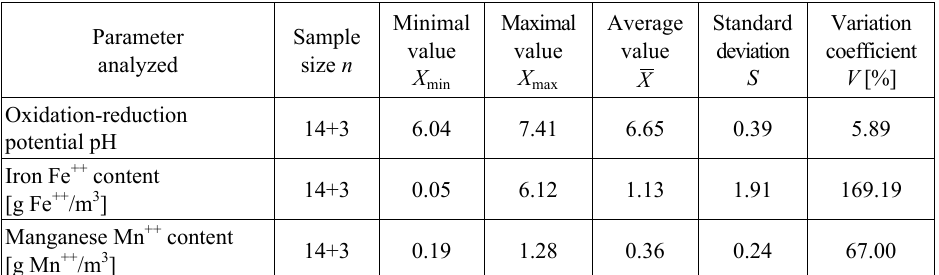
Table 3. Basic statistics of quality parameters of underground water in the intake area in the region of Kłodzko (14 wells + 3 piezometers) (years: